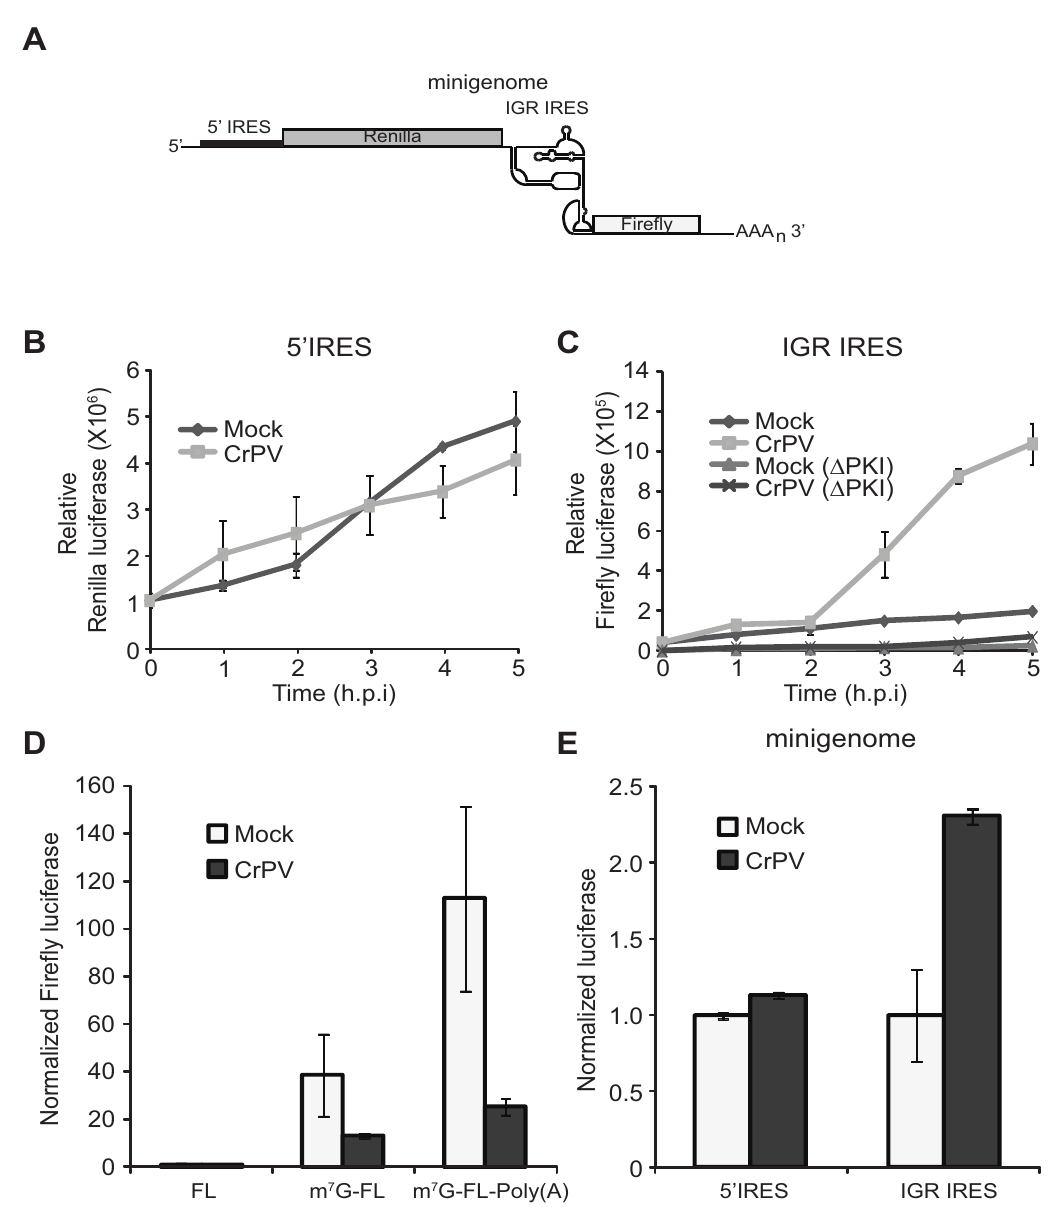
Figure 3. CrPV 5'UTR and IGR IRES translation. ( A ) Schematic of the CrPV minigenome; ( B , C ) S2 cells were transfected with the CrPV minigenome RNA one hour prior to mock or CrPV infection. Cells were harvested at the indicated time points and assayed for ( B ) Renilla or ( C ) firefly luciferase activity. A mutation within the IGR IRES ( Δ PKI), which disrupts pseudoknot I of the IRES, was used to validate that IGR IRES activity was monitored; ( D ) Monocistronic firefly RNA (FL), 5'-capped monocistronic firefly RNA (m 7 G-FL), and 5'-capped and polyadenylated monocistronic firefly RNA were incubated in S2 translation extracts for thirty minutes and assayed for firefly luciferase activity. The results are normalized to FL incubated in mock extracts; ( E ) Minigenome RNA was incubated in S2 translation extracts from mock or infected cells for thirty minutes and assayed for Renilla and firefly luciferase activities. The results are normalized to mock extracts. ( D , E ) Averages are shown from at least three independent experiments (±s.d.).